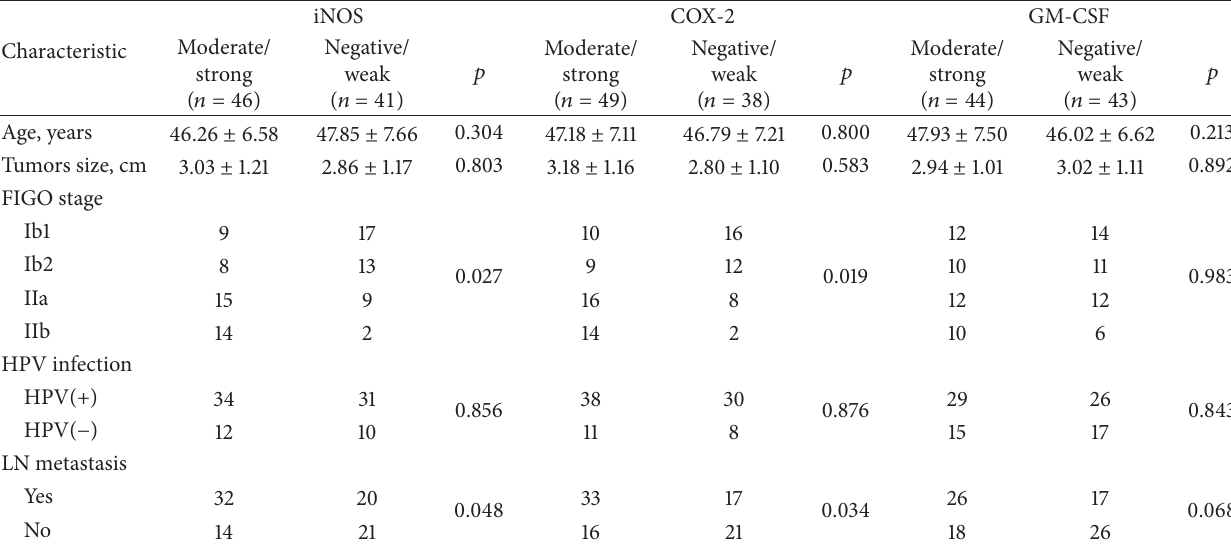
Table 2: Patient characteristics.